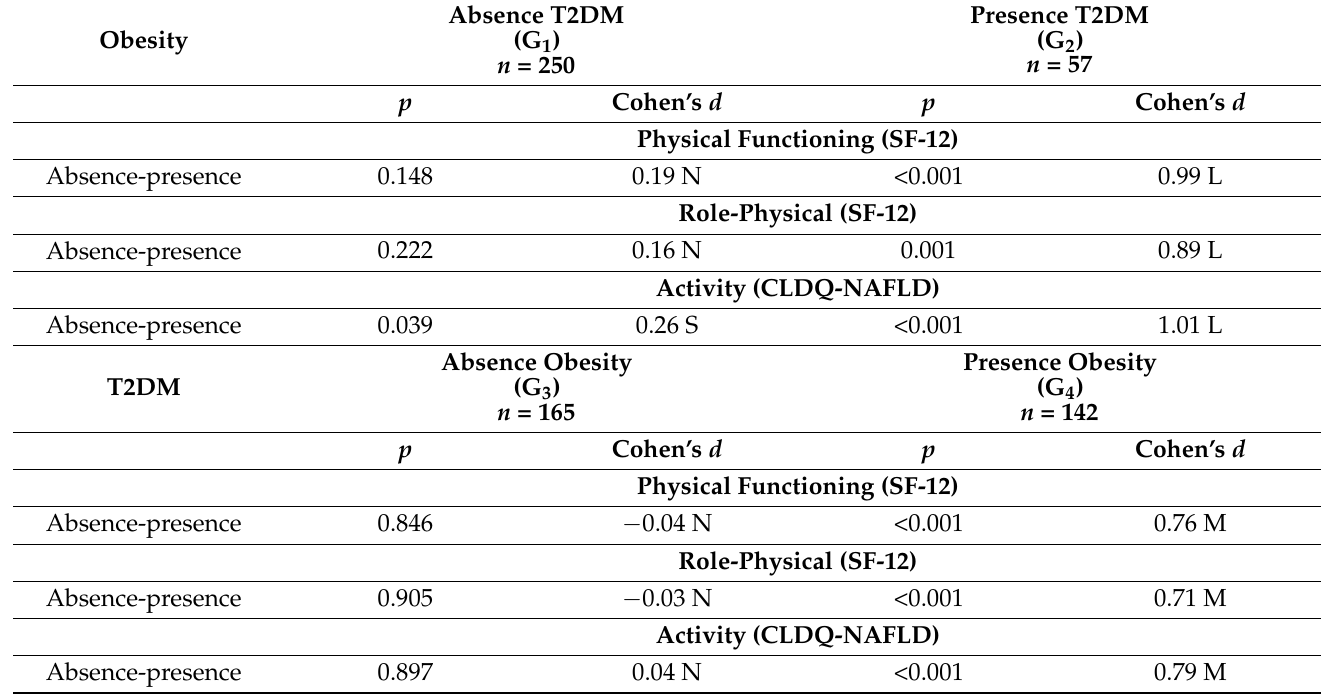
Table 4. Simple Effects in Physical Functioning (SF-12), Role-Physical (SF-12) and Activity (CLDQ-NAFLD).